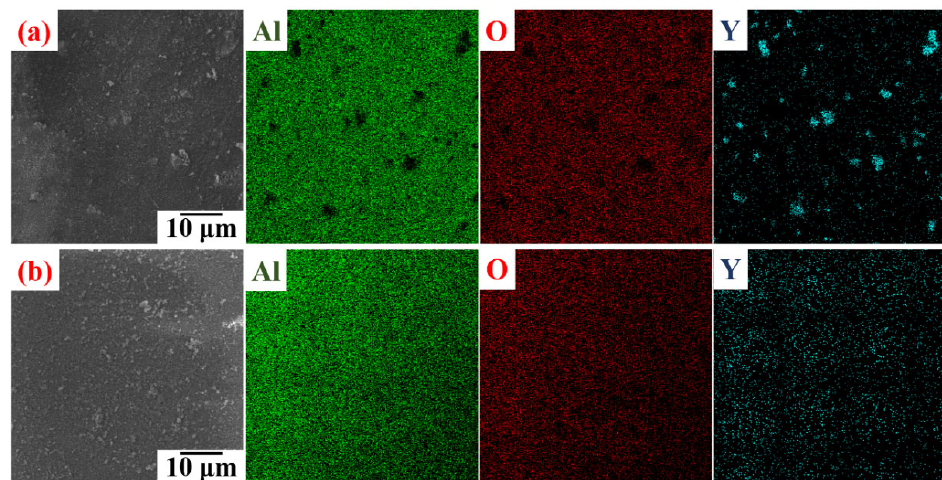
Fig. 7 SEM images of the printed green surfaces of Samples: (a) MM and (b) CP and corresponding EDS mapping results for Al, O, and